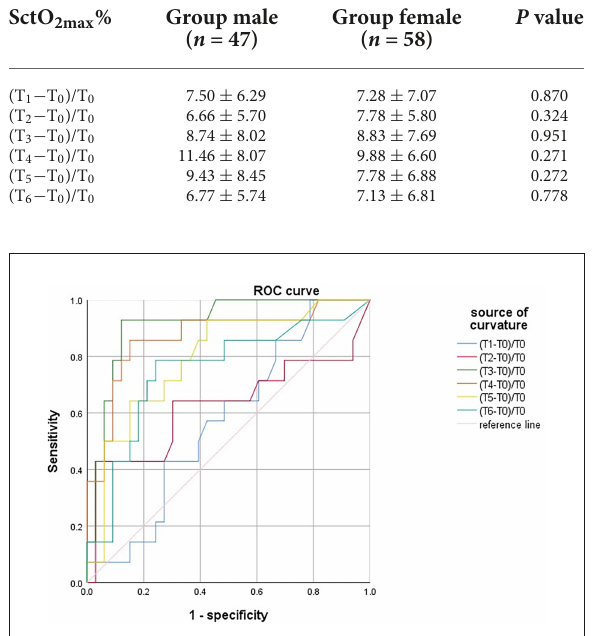
FIGURE5 ROC curve analysis of PND predicted by the maximum percentage decline of SctO 2 in males at each time point. the adverse reaction of a single drug. Hence, we divided the